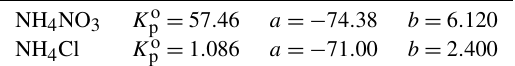
Table 4. Equilibrium dissociation constants [ ppbv 2 ] and T coeffi- cients [−] ; from Fountoukis and Nenes (2007). NH 4 NO